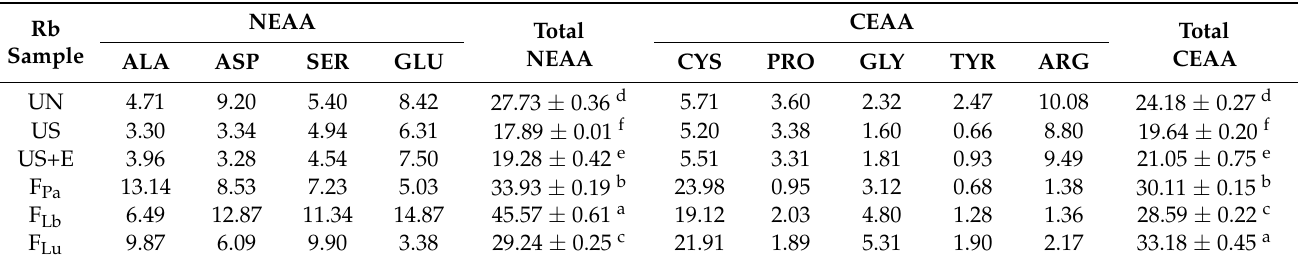
Table 3. Non-essential (NEAA) and conditionally essential amino acids (CEAA) (g/100 g protein) in rice bran (RB) after different